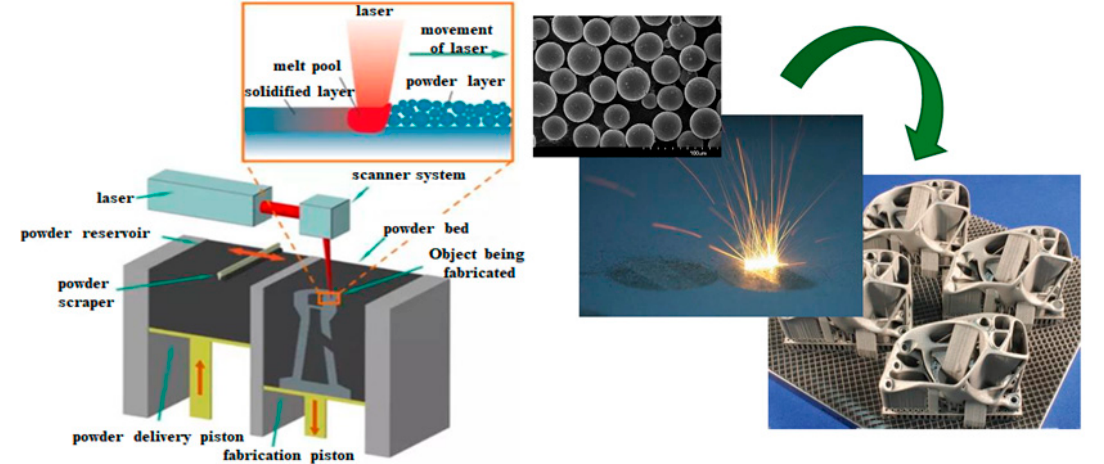
Figure 1. Example of 3D printing structure production [16].